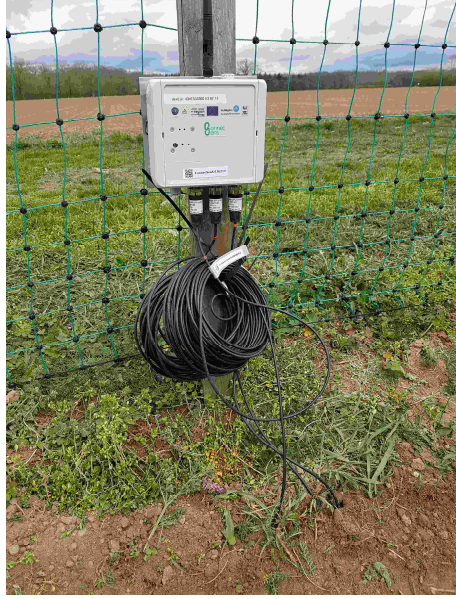
Figure 11. SoLo nodes deployed on the Montoldre